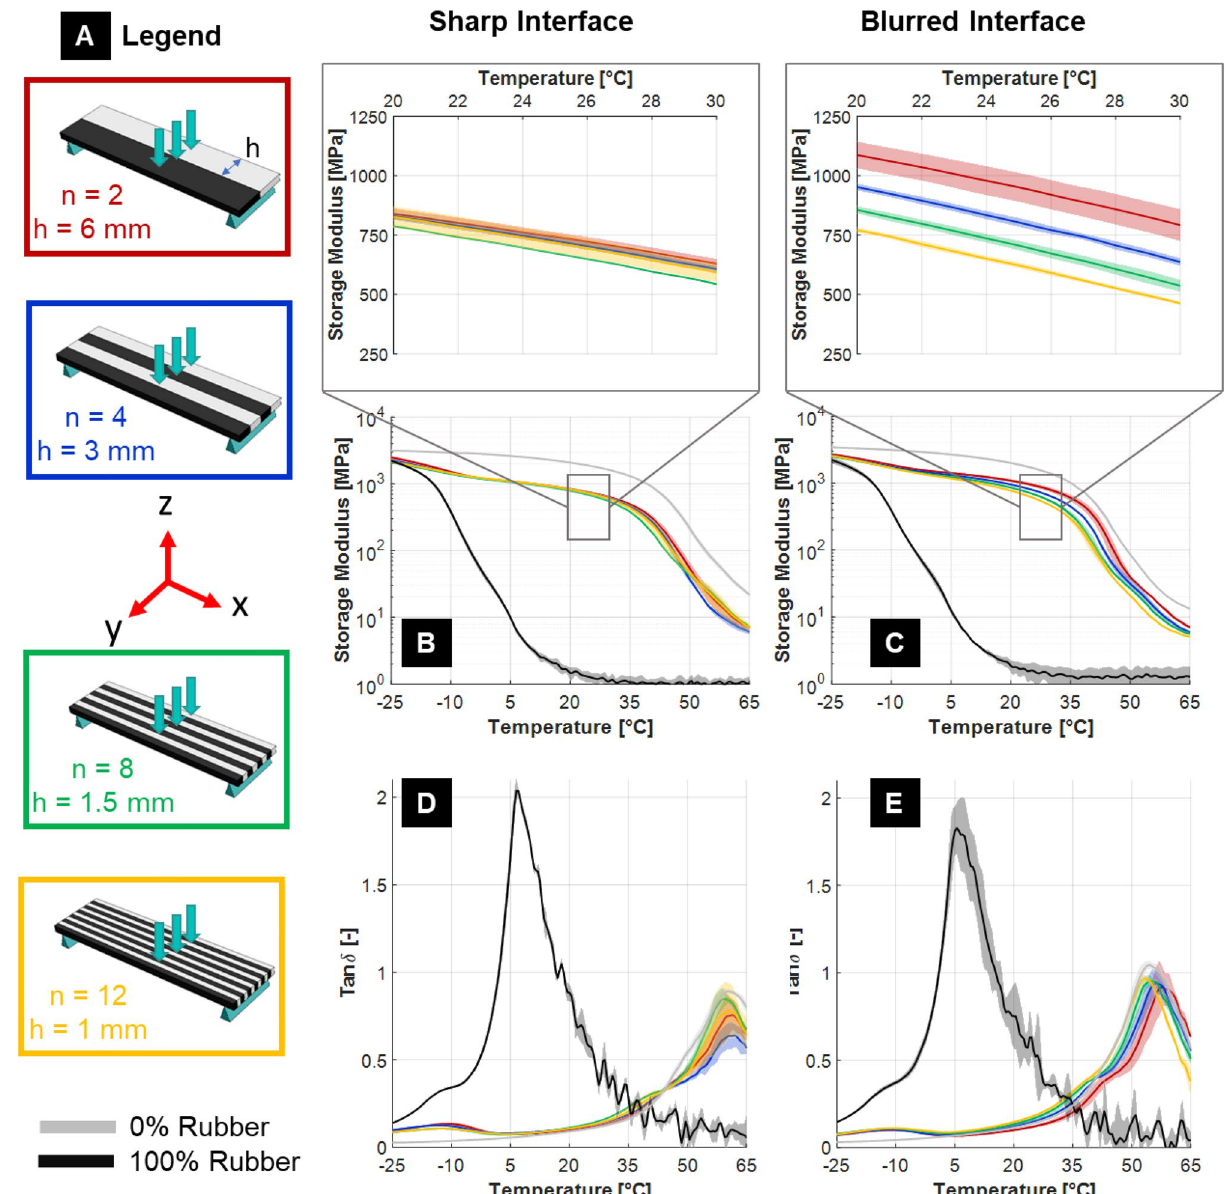
Figure 4. ( A ) Configurations with layers stacked along the width of the samples (n is the total number of layers and h is the layer width). ( B ) Storage modulus and ( D ) loss factor (Tan δ ) for composites having sharp bimaterial interfaces (i.e. formed after UV curing). ( C ) Storage modulus and ( E ) loss factor (Tan δ ) for composites having blurred bimaterial interfaces (i.e. formed before UV curing). The magnifications show detailed trends in the temperature range 20–30 °C. Data reported as mean value over three replicates with shaded area representing one standard deviation interval. Reference curves for pure materials (black TB + and light grey VW +) are also position did not vary when increasing the number of layers (Fig. 5D). As for the blurred interface scenario, the intermediate peak moved towards higher temperature and became broader when having more layers (Fig. 5E). The presence of this peak in the loss factor may be related to the blending of the two photopolymers, causing the formation of a “third’’ material at the interface. The fact that this additional phase became visible in the loss fac- tor is probably due to the geometry of samples with layers stacked along the thickness, together with the regular arrangement of the interfaces. Even if such intermediate peak is present in both sharp and blurred scenarios, its magnitude, position and width are substantially different. Indeed, the amount of blending is expected to be larger with respect to the configuration with layers stacked along the width of the sample, for a given number of layers, the more so considering a blurred rather than a sharp interface. As peak characteristics are likely influ- enced by the number of layers, the extension of the interface and its location, it is challenging to draw additional conclusions on the blending between TB + and VW + from the analysis of the loss factor. The geometry of the